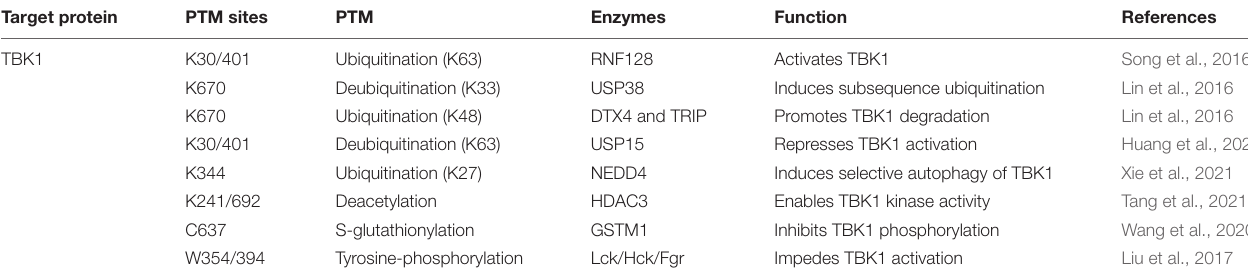
TABLE 3 | Modifications of TBK1 in regulating IFN-I